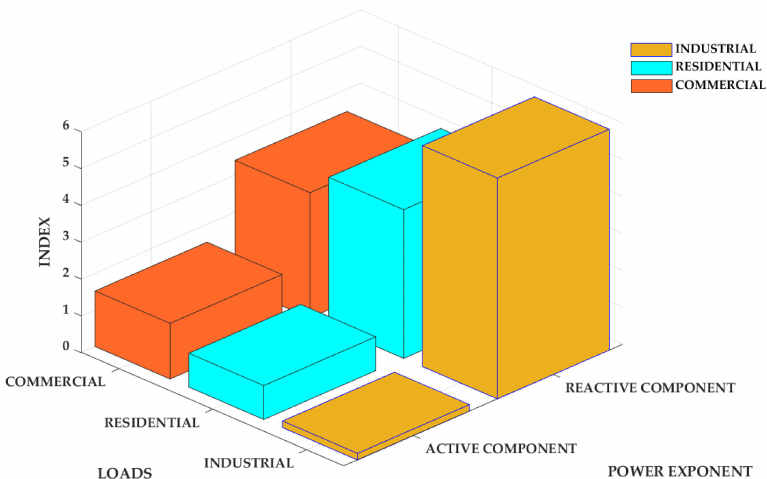
Figure 2. Load types with power